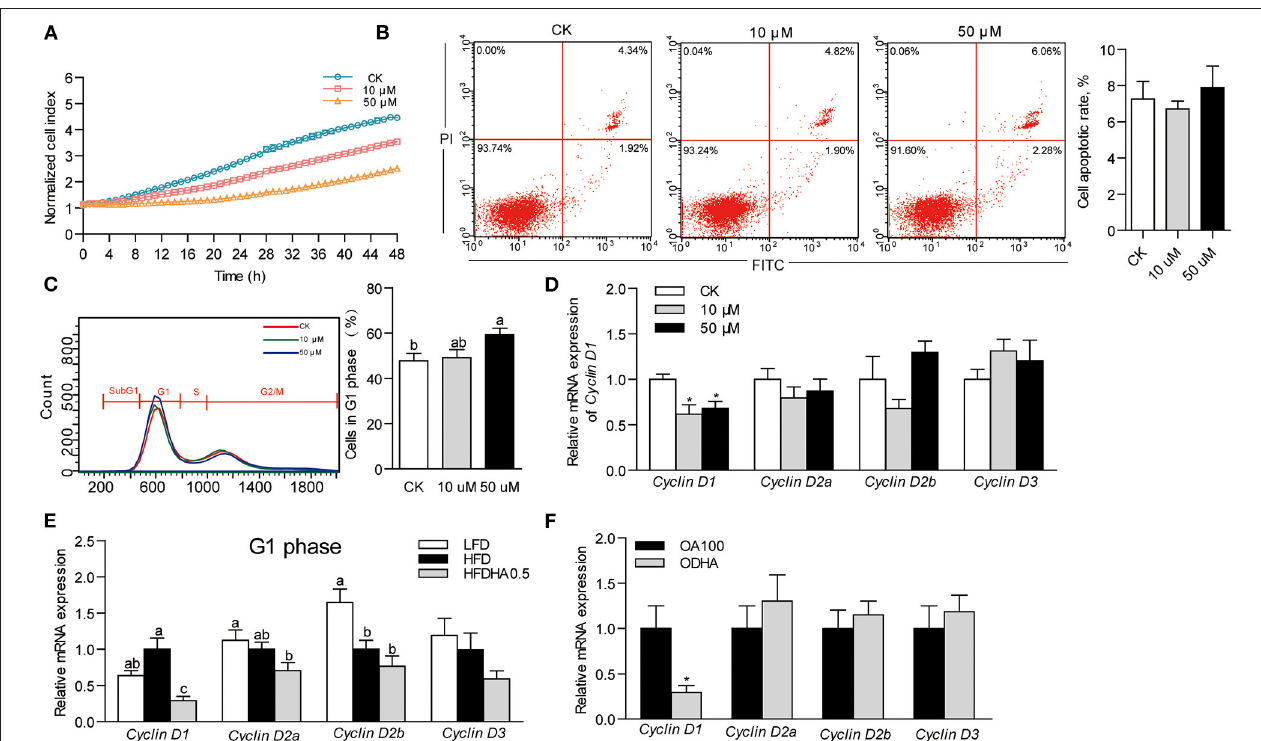
FIGURE 4 | Effects of DHA on cell growth, cell apoptosis and cell cycle. (A) Growth of ZFL cells treated with DHA for 48h. (B) Cell apoptosis and (C) cell cycle of ZFL treated with DHA at 24h. (D) Relative mRNA expression of genes encoding D-type Cyclins in ZFL cells. (E) Relative mRNA expression of genes encoding D-type Cyclins in the liver of LFD, HFD, and HFDHA0.5-fed zebrafish. (F) Relative mRNA expression of genes encoding D-type Cyclins in ZFL cells treated with OA and ODHA. Values are means ± SEMs ( n = 3-5 biological replicates). Means without a common letter are significantly different, P < 0.05. * P < 0.05.